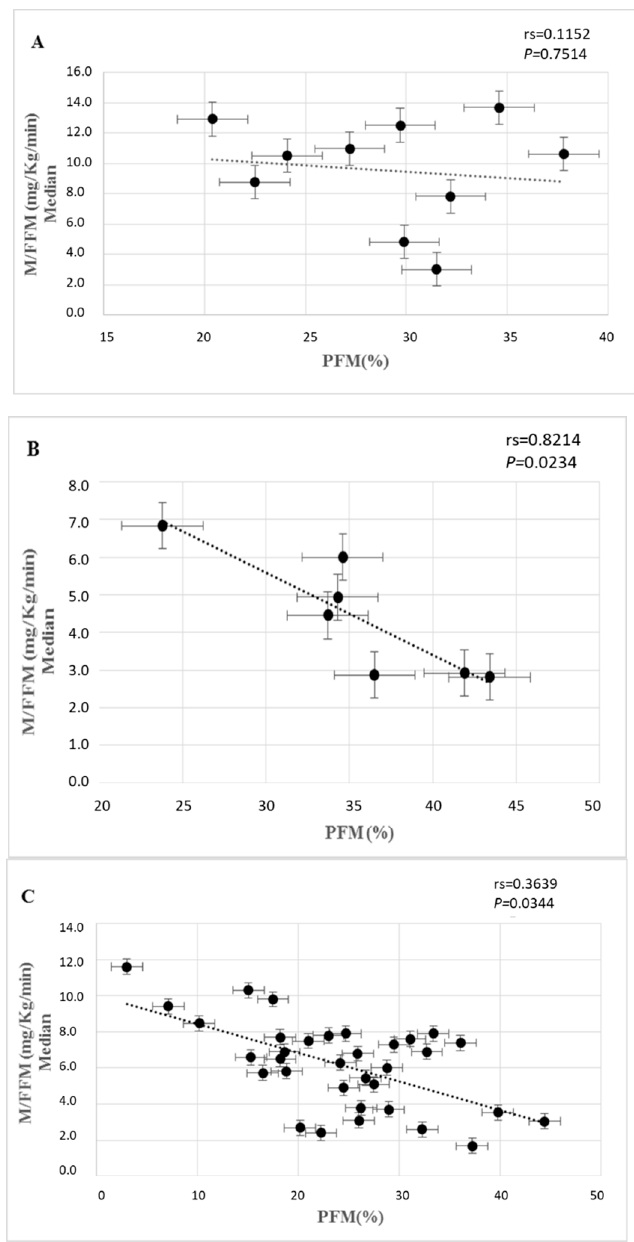
Figure 3. Correlation between insulin sensitivity and percentage of fat mass in patients with COGHD ( A ), patients with AOGHD ( B ), and all control subjects ( C ). Abbreviations: rs: Spearman correlation coefficient.